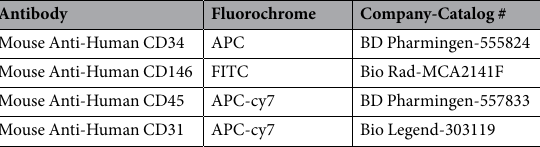
Table 2. Antibodies used in fluorescence activated cell